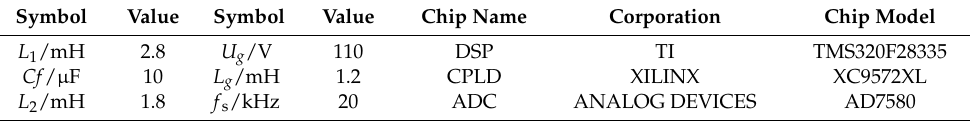
Figure 25. The THD analysis of harmonic load current. Table 7. The electric parameters of HCGIs system and the chips used in the controller.